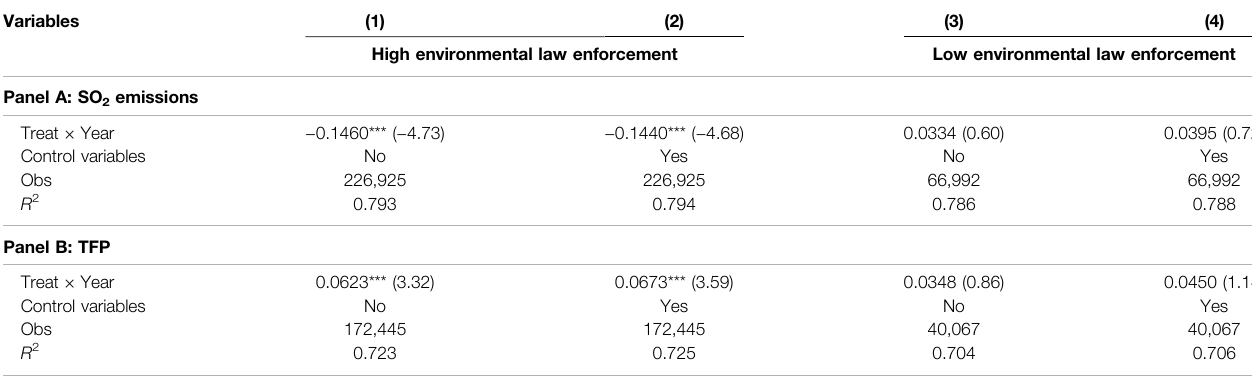
TABLE 11 | Heterogeneity regression results of environmental law enforcement.